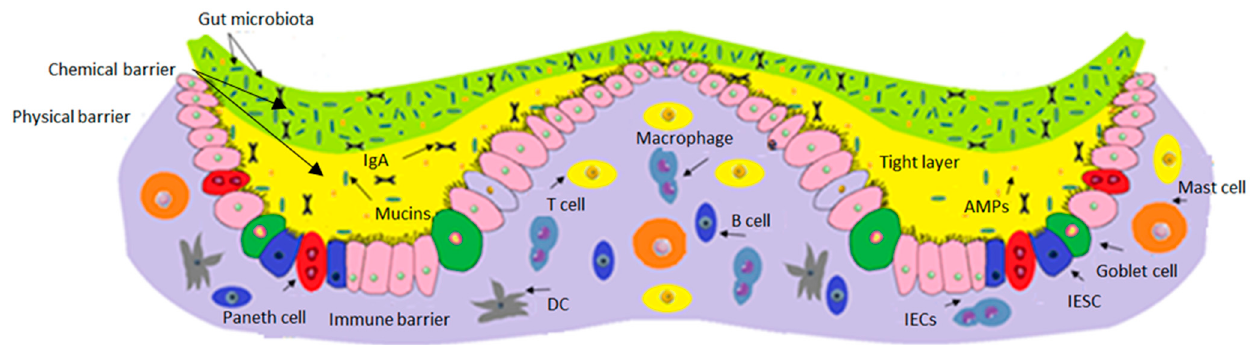
Figure 3. Composition and anatomical structure of the gut barrier.